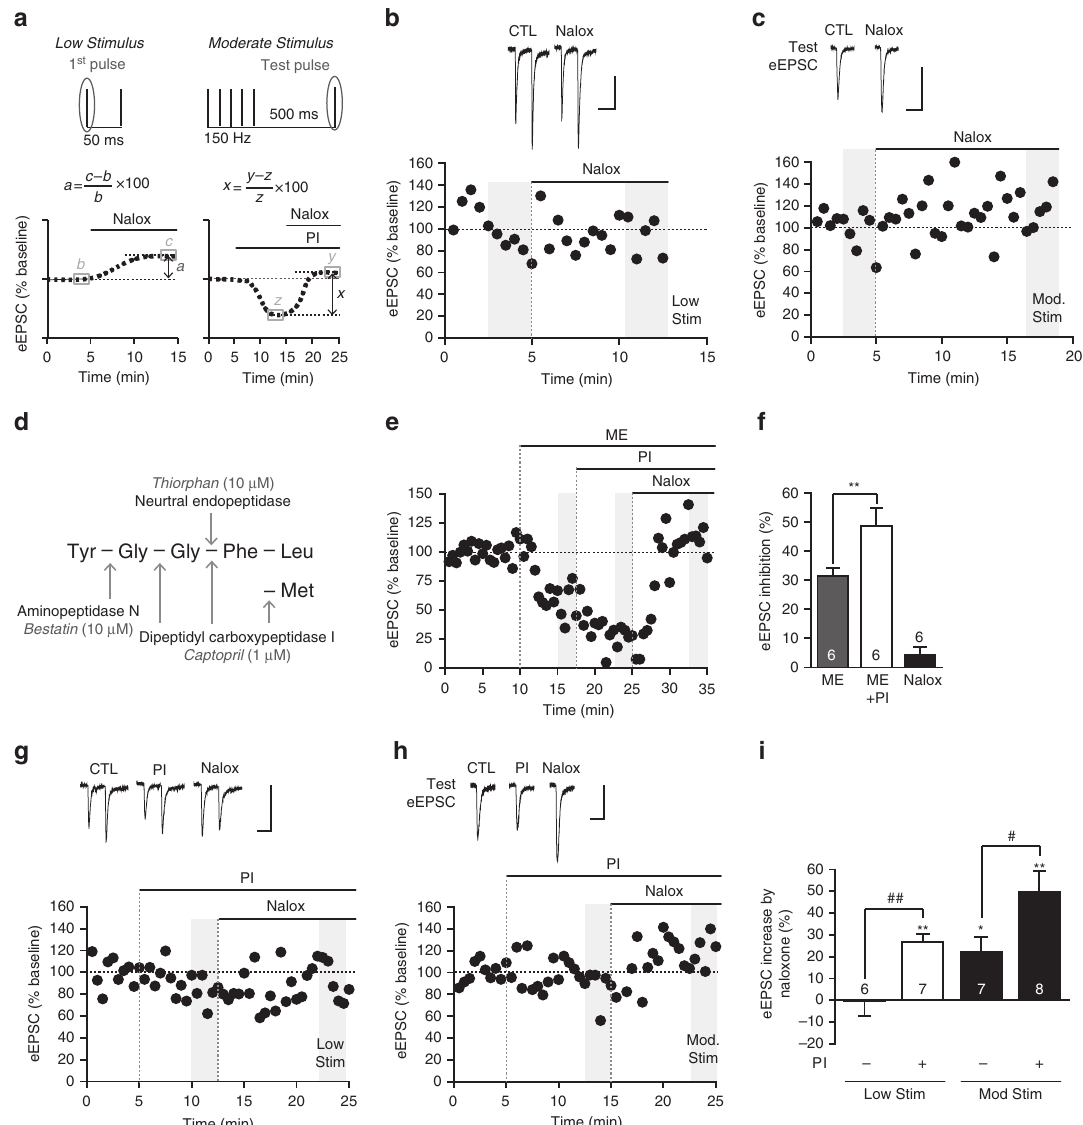
Figure 3 | Endogenously released opioids inhibit glutamate release at the BLA-ITC synapse. ( a ) Graphic showing stimulus paradigms and calculation of endogenous opioid effect. ( b ) Naloxone (Nalox, 10 m M) has no effect on eEPSC amplitude when evoked with a low stimulus, ( c ) while amplitude of the moderate stimulus ‘test eEPSC’ is increased by naloxone. Data displaying eEPSCs and time plots of single representative experiments. ( d ) Met/leu- enkephalin is catabolized by specific peptidases; diagram showing cleavage sites, peptidases and their corresponding inhibitors (PIs). ( e , f ) Inhibition of eEPSC amplitude with submaximal ME (300–500nM) is potentiated by peptidase inhibitors (PI; thiorphan 10 m M, captopril 1 m M, bestatin 10 m M). ( e ) Representative time plot and ( f ) bar chart showing percentage inhibition of eEPSC amplitude (from baseline). When peptidases are inhibited, naloxone now ( g ) increases synaptic responses evoked with the low stimulus and ( h ) produces a larger increase in amplitude of the moderate stimulus test eEPSC. Data displaying eEPSCs and time plots of single representative experiments. ( i ) The increase in synaptic response by naloxone increases with greater stimulus intensity and/or inclusion of PIs. Bar chart shows mean increase by naloxone (%) across each condition (Data are represented as mean ± s.e.m.; * P o 0.05, ** P o 0.01, paired t -tests, versus CTL; # P o 0.05, ## P o 0.01, unpaired t -tests as indicated). Highlighted regions on time plots represent region sampled for bar charts. Scale bars, 50ms,